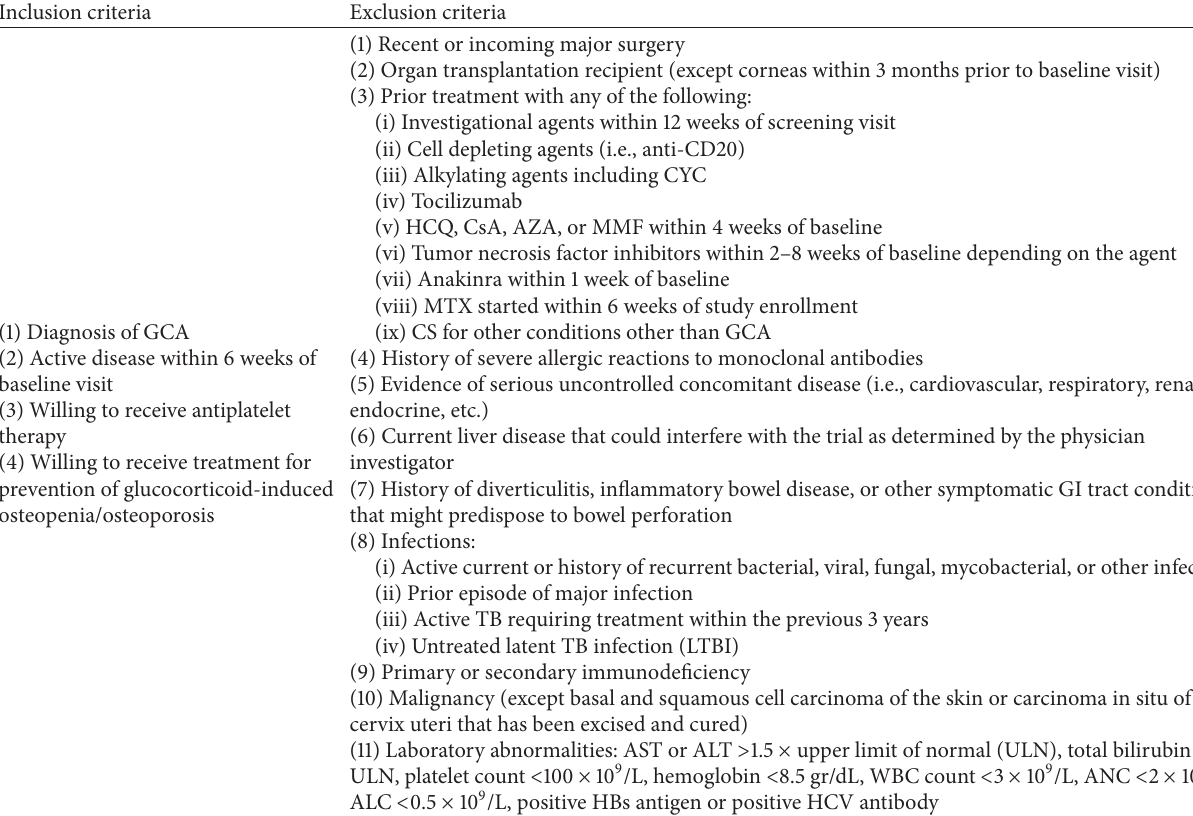
Table 2: Eligibility